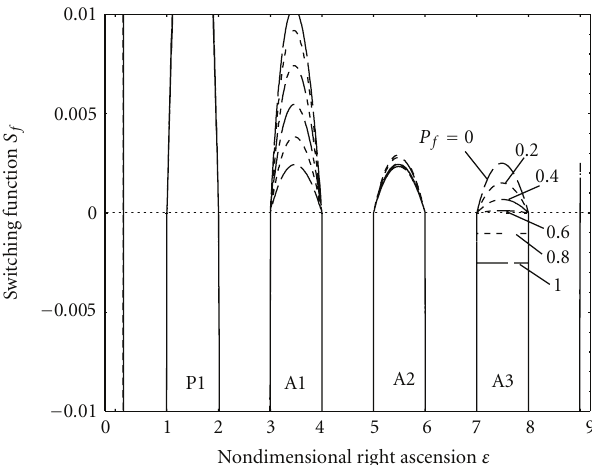
Figure 12: Switching function history for 4.5-revolution transfer departing on December 1, 2015.